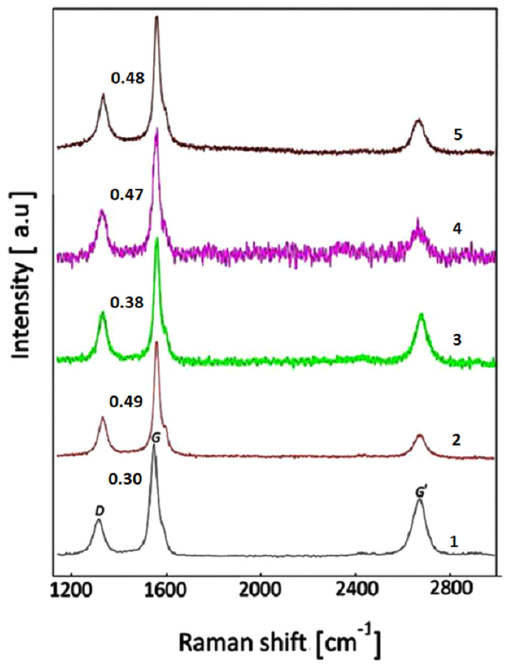
Figure 5. Raman spectra of the samples: 1—pristine MWCNTs, 2—MWCNTs/Cu (physical method), 3—f-MWCNTs, 4—f-MWCNTs/Cu (physical method), and 5—f-MWCNTs (chemical method) with calculated I(D)/I(G) relation.